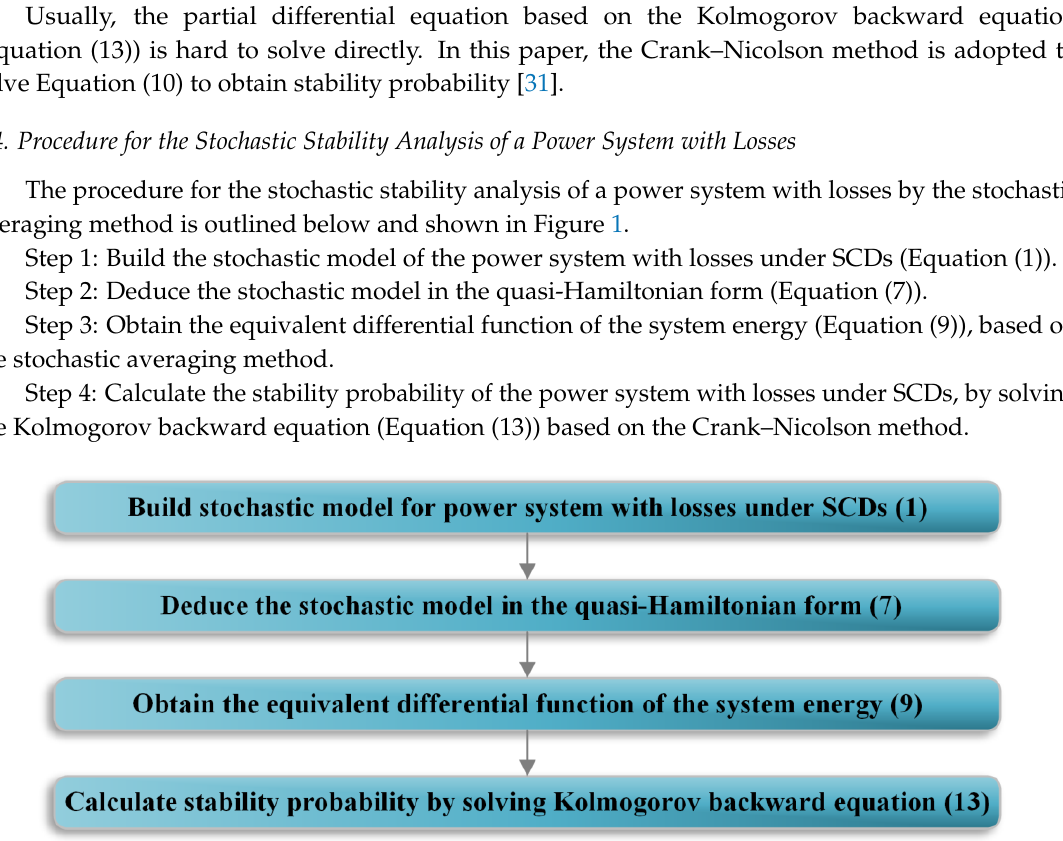
Figure 1. The procedure of the proposed stochastic stability analysis method. SCD: stochastic disturbance.